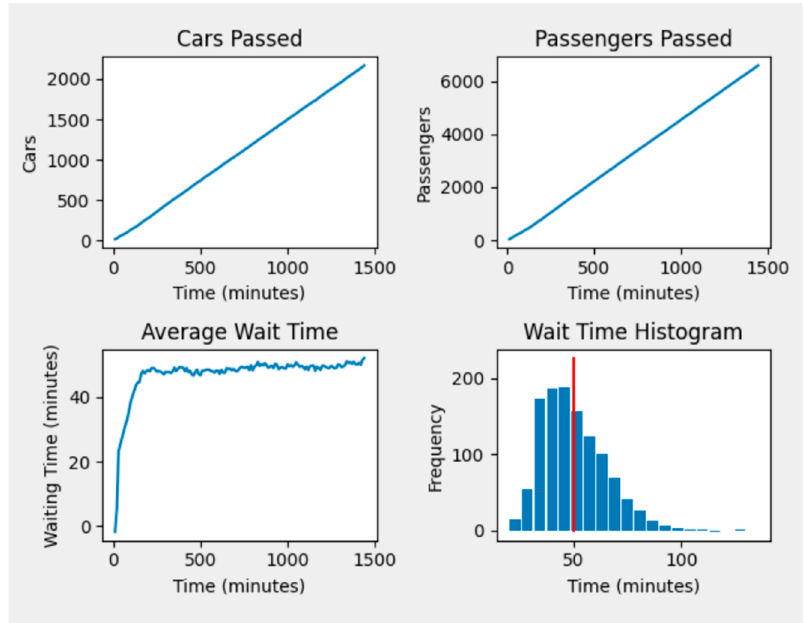
Figure 6. Example of our model predictions for a set of input parameters. All time data is sampled on 10 min intervals but can easily be adjusted for finer grain information. Wait time distributions align with pre ‐ observed results directly from the AnyLogic model. Red line represents mean wait time.